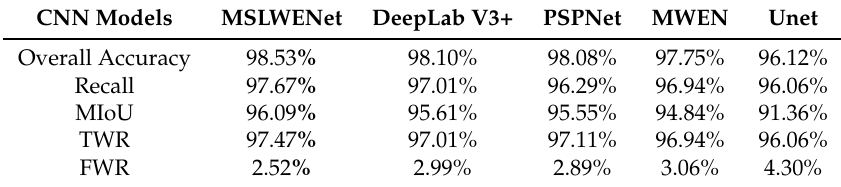
Table 1. The metrics of the CNN models in the testing phase. MSLWENet, multi-scale lake water